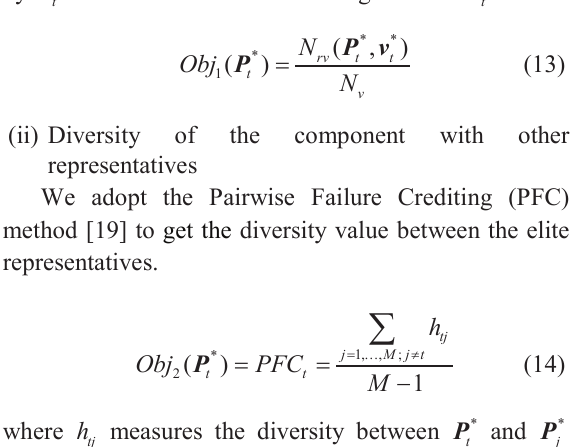
Table 1. Performance of AGEM and Initial Ensemble